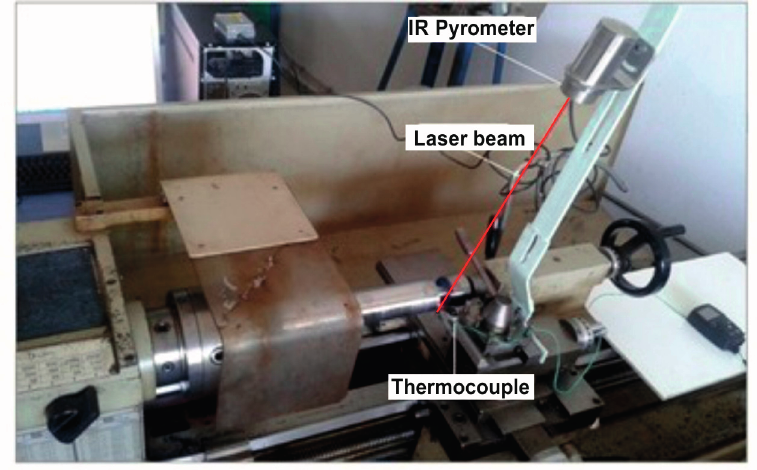
Figure 9. Thermocouple and IR pyrometer connections onto the